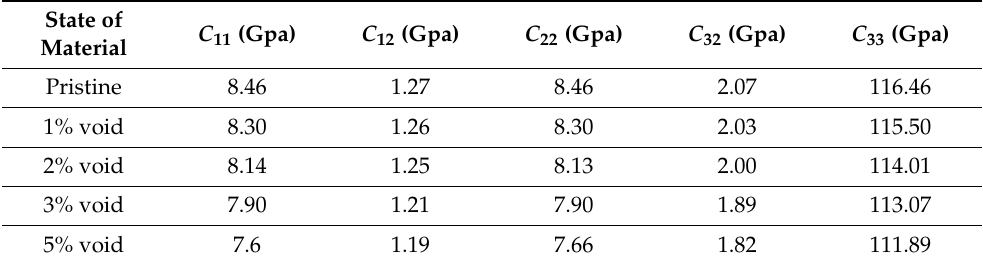
Table 3. Failure loads of unidirectional plates with different hole orientations and fiber directions obtained by the tensile test.